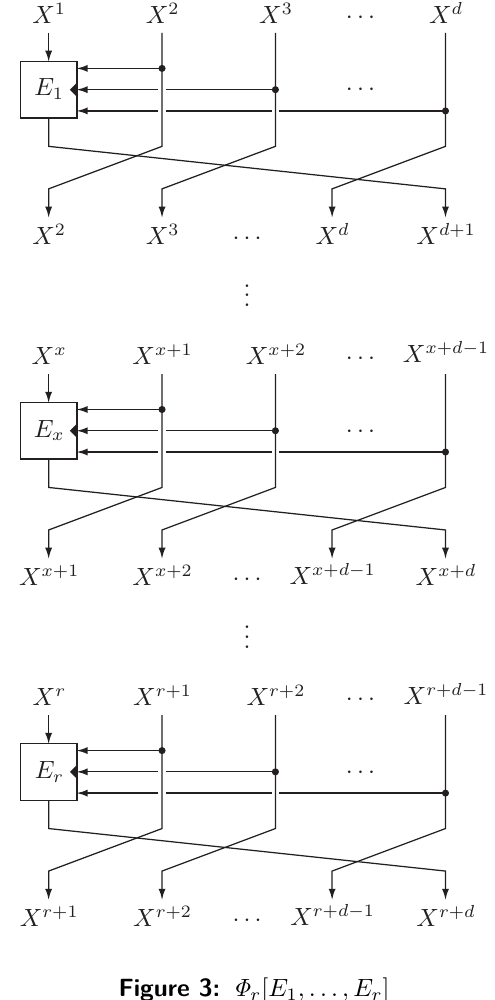
Figure 3: Φ r [ E 1 , . . . , E r